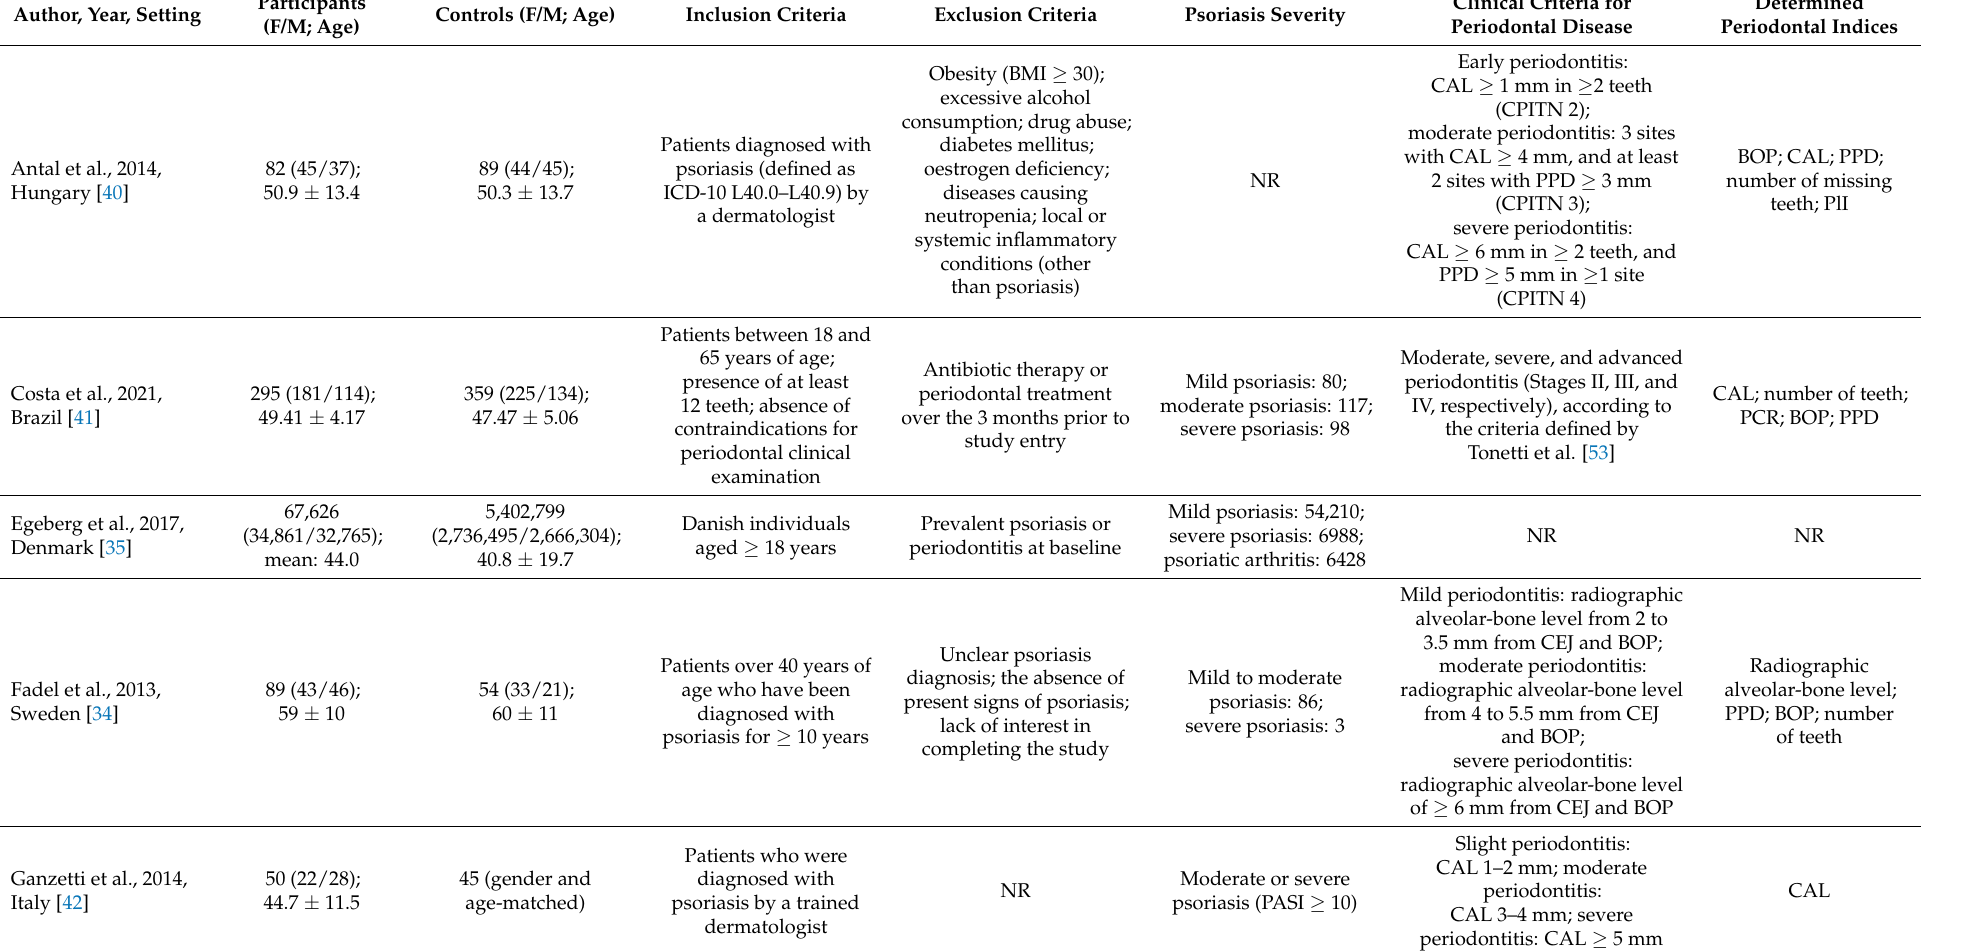
Table 2. General characteristics of included